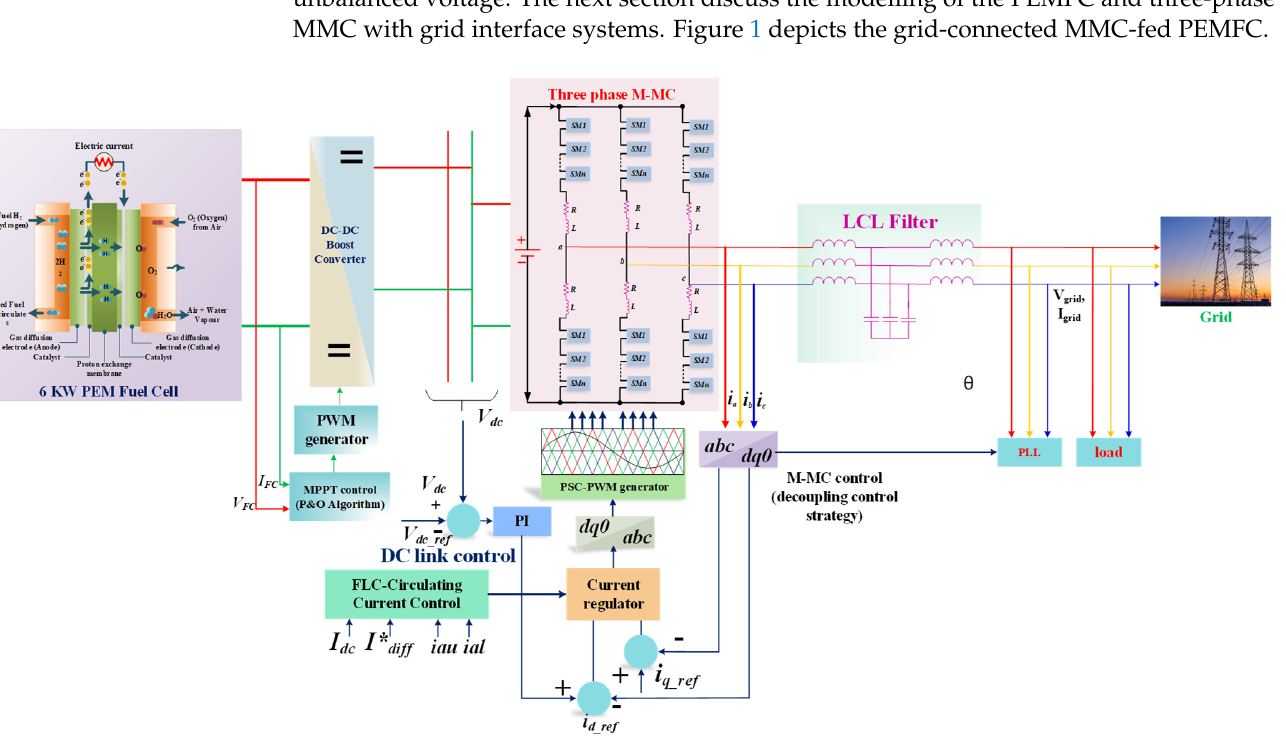
Figure 1. The system architecture of threephase gridconnected MMCfed PEMFC.